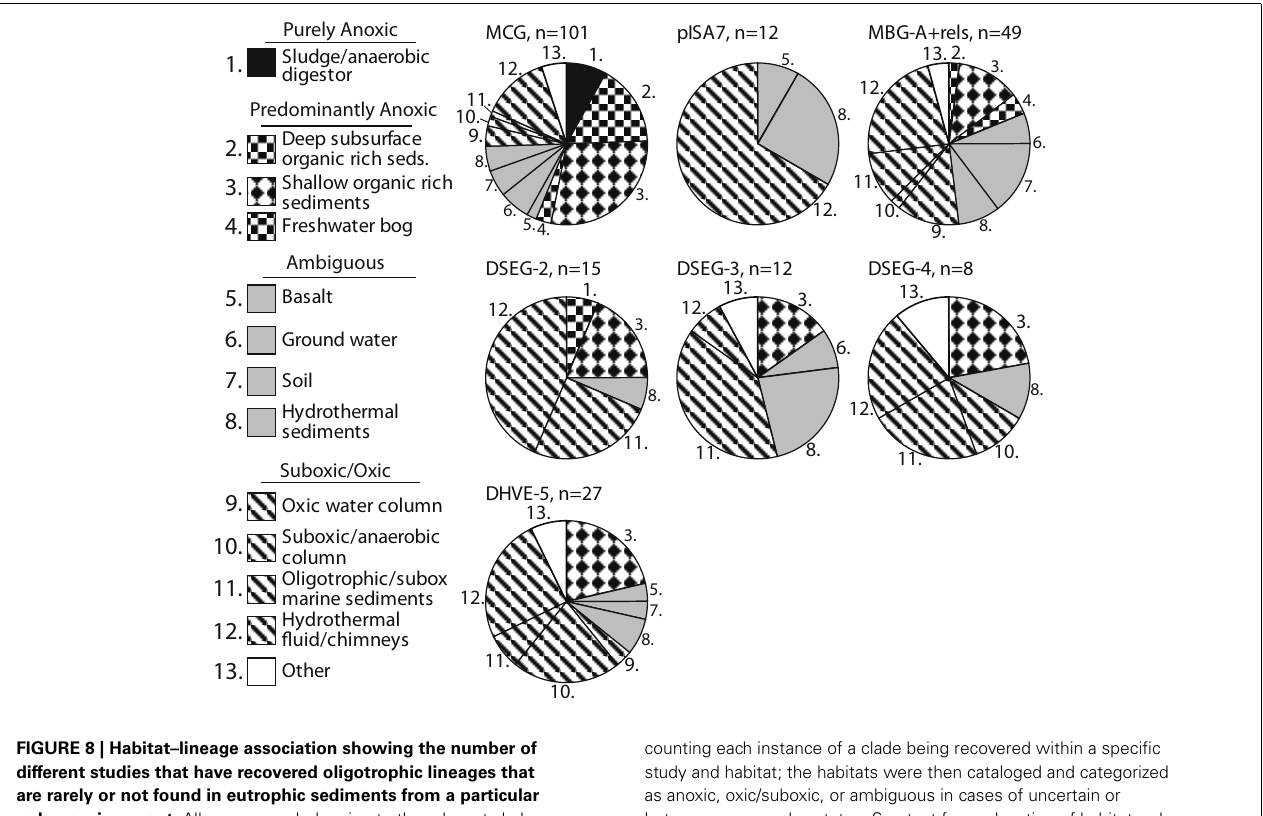
FIGURE 8 | Habitat–lineage association showing the number of different studies that have recovered oligotrophic lineages that are rarely or not found in eutrophic sediments from a particular redox environment. All sequences belonging to the relevant clades in SILVA SSU RefV.95 (Pruesse et al., 2007) were examined by